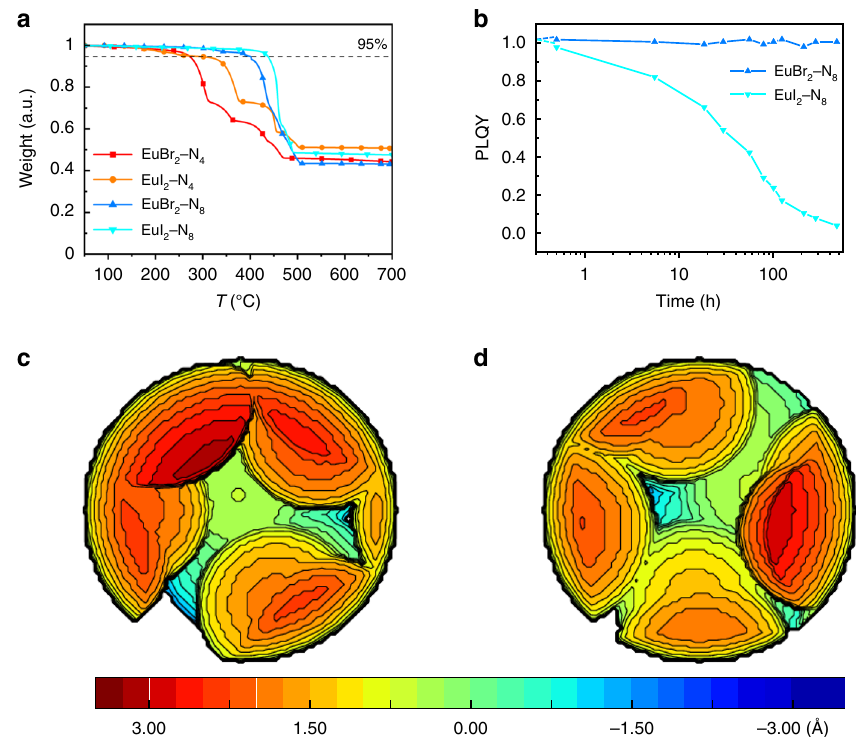
Fig. 3 The thermal properties and buried volume calculation of Eu X 2 -N n compounds. a Thermogravimetric analysis (TGA) of Eu X 2 – N n , where the 95%- weight line is shown to determine the T d . b The change in PLQY of Eu X 2 – N 8 complexes in air. c Buried volume % V bur calculated of EuBr 2 – N 8 (77.0%). d Buried volume % V bur calculated of EuI 2 – N 8